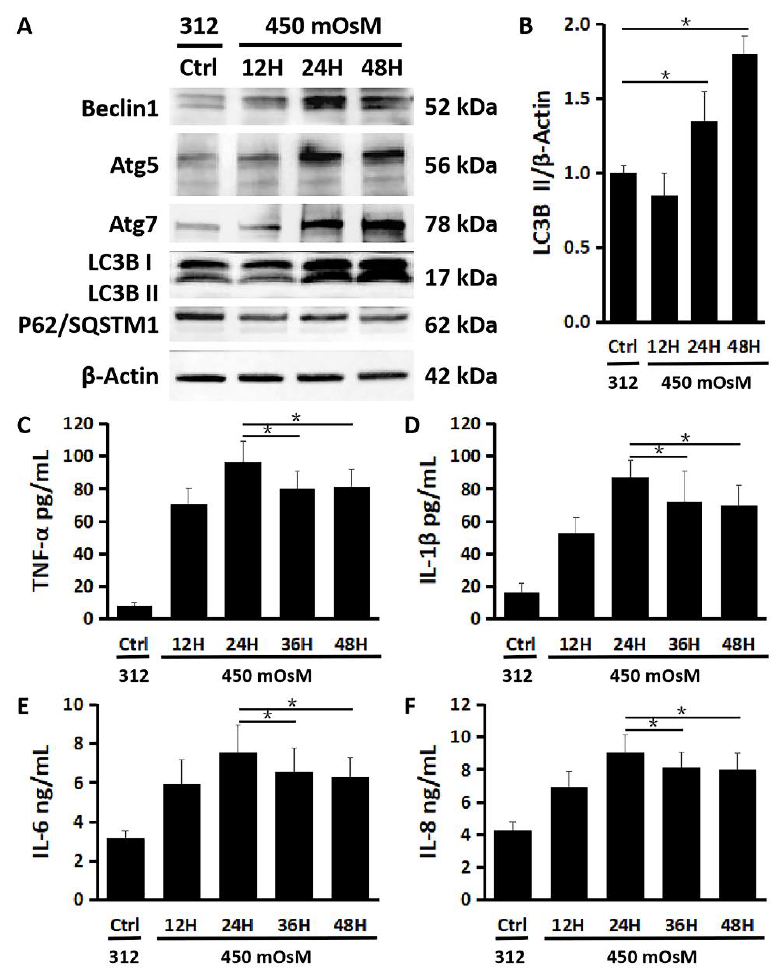
Figure 3. Time-dependent effect of hyperosmotic stress on autophagy activation and inflammation in primary HCECs. ( A ) Western blot showed that the protein production of Beclin1, Atg5 and Atg7, as well as LC3B turnover increased while production of p62/SQSTM1 decreased significantly in 24–48 h after HCECs were exposed to 450 mOsM medium, with β-Actin serving as internal control. ( B ) Quantitative ratio of LC3B II/β-Actin showing increased LC3B turnover in 24–48 h after HCECs were exposed to 450 mOsM. ( C – F ) ELISA analyses. The pro-inflammatory cytokines, TNF-α ( C ), IL-1β ( D ) and IL-6 ( E ), as well as chemokine IL-8 ( F ) was suppressed after 24 h in HCECs exposed to 450 mOsM. Data are mean ± SD of three independent experiments. * p < 0.05, compared within groups.